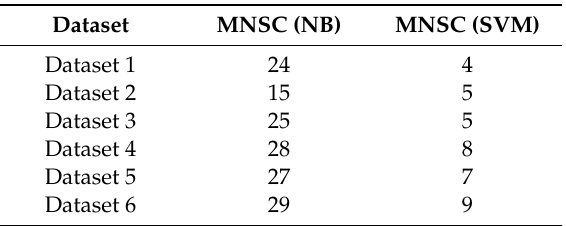
Table 3. Classification results with